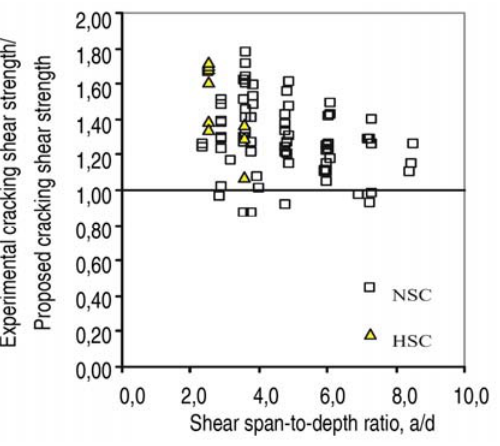
Fig. 8. Comparing experimental cracking shear strength values with proposed cracking shear strength of Eq (15) for various compressive strength